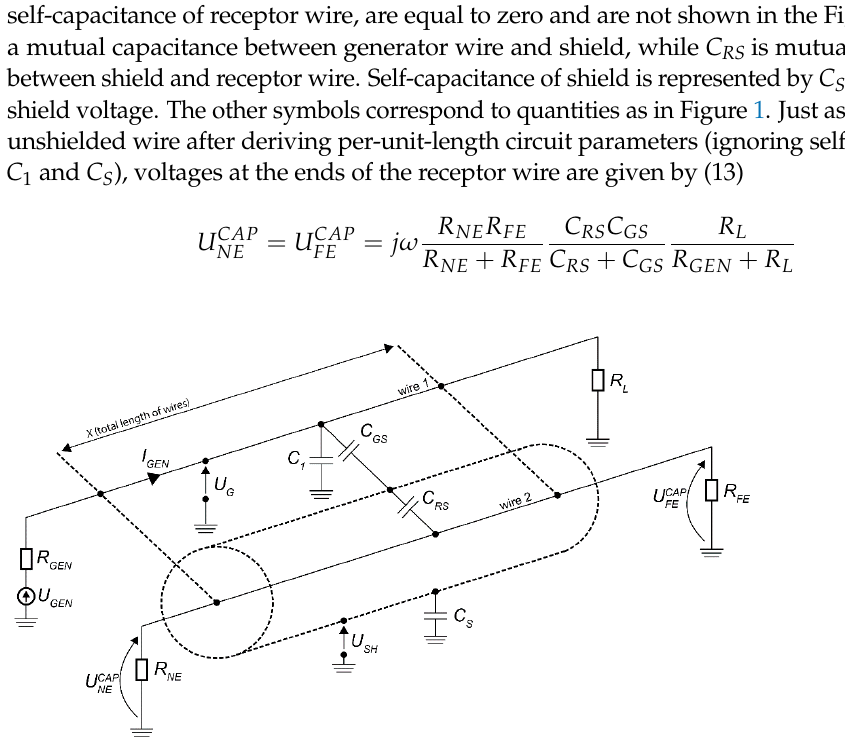
Figure 2. Example of capacitive coupling between aggressor wire and shielded victim wire.